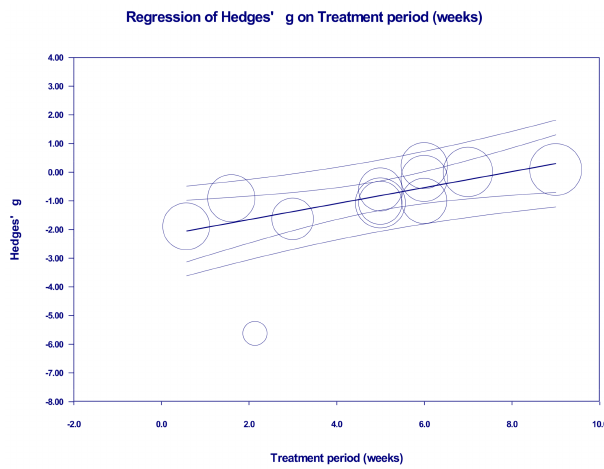
Figure 4. Meta-regression analysis for Hedges’ g of blood glucose levels and treatment period in DM rodents treated with or without rooibos extracts or major phenolic compounds. Summary estimates were analyzed using a random-effects